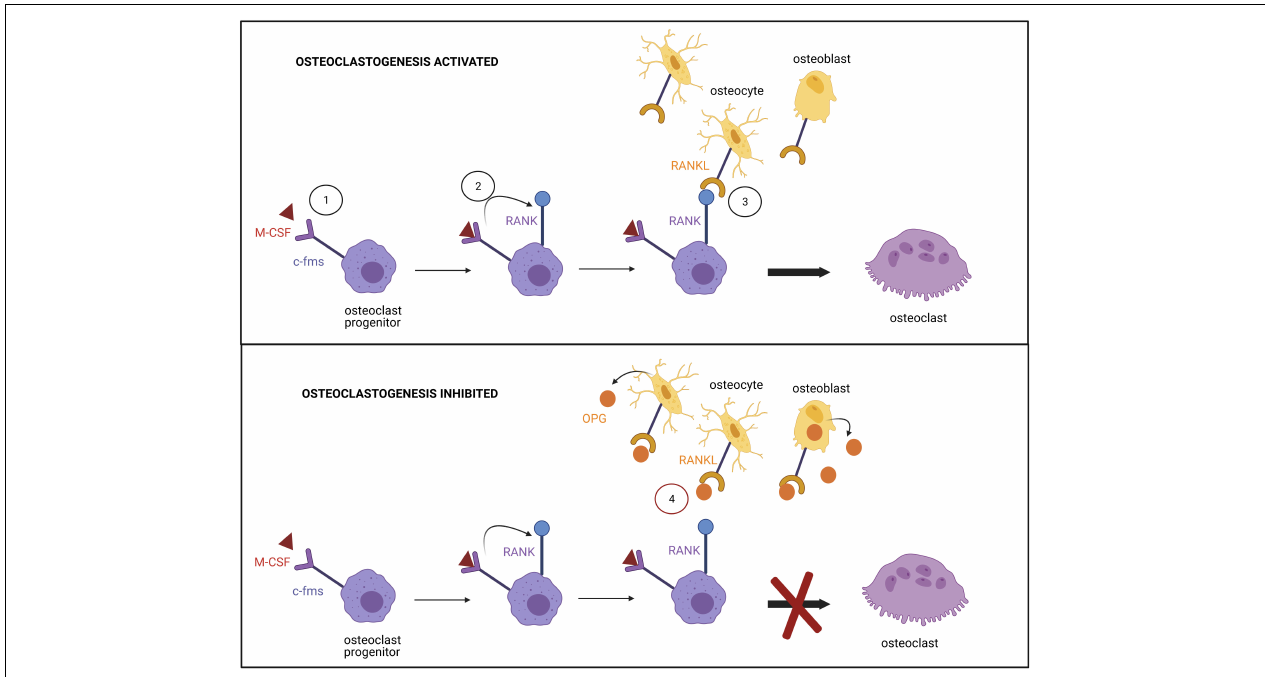
FIGURE 6 | Regulation of the osteoclast differentiation. (1) Binding of M-CSF to its receptor c-fms at the surface of osteoclast progenitor promotes (2) RANK expression. (3) Signaling induced by the binding of RANK to RANKL, expressed by osteocytes and osteoblasts, triggers transcription factor activation and osteoclast differentiation. (4) The differentiation is prevented by the high affinity association of osteoprotegerin (OPG), produced by osteoblasts, to